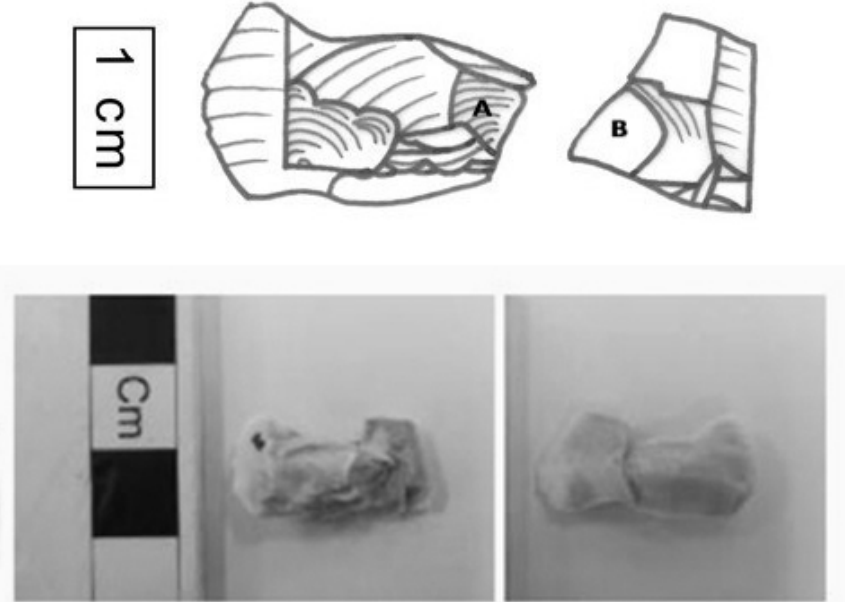
Figure 22. MP19a (12x19x4 mm) and MP22a (12x11x3 mm) conjoining pieces (A sits on B) indicative of vertical sequential reduction (drawing by the